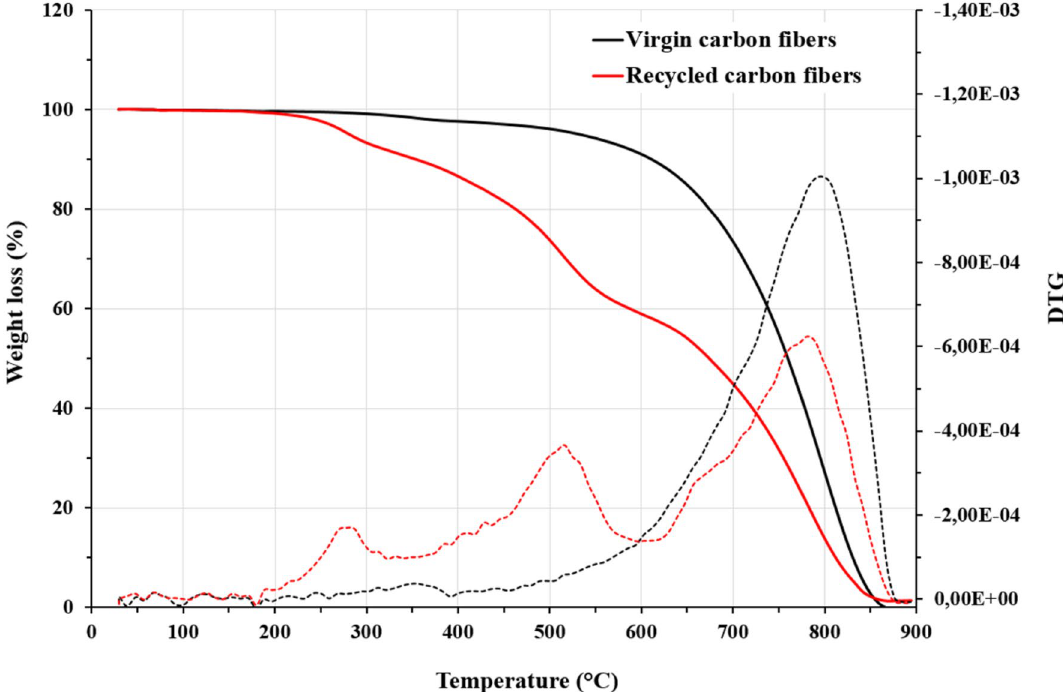
Figure 4. TGA and DTG curves of virgin and recycled carbon